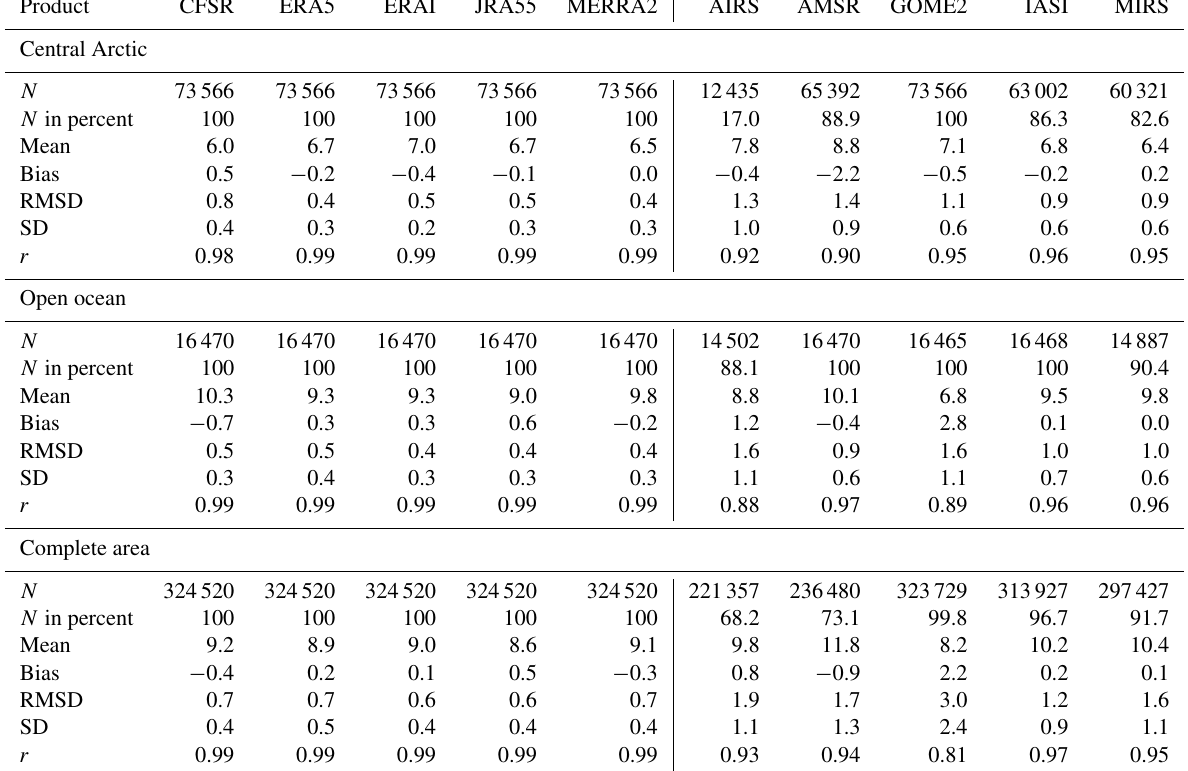
Table 2. Skill scores for the intercomparison of daily IWV mean to reanalysis median in May and June 2017 for all valid data pairs in terms of bias, SD and RMSD (all in kgm − 2 ) and correlation coefficient ( r ). Results have been calculated for the central Arctic, open ocean and the complete study taking into account the area of the different grid cells. N denotes the number of